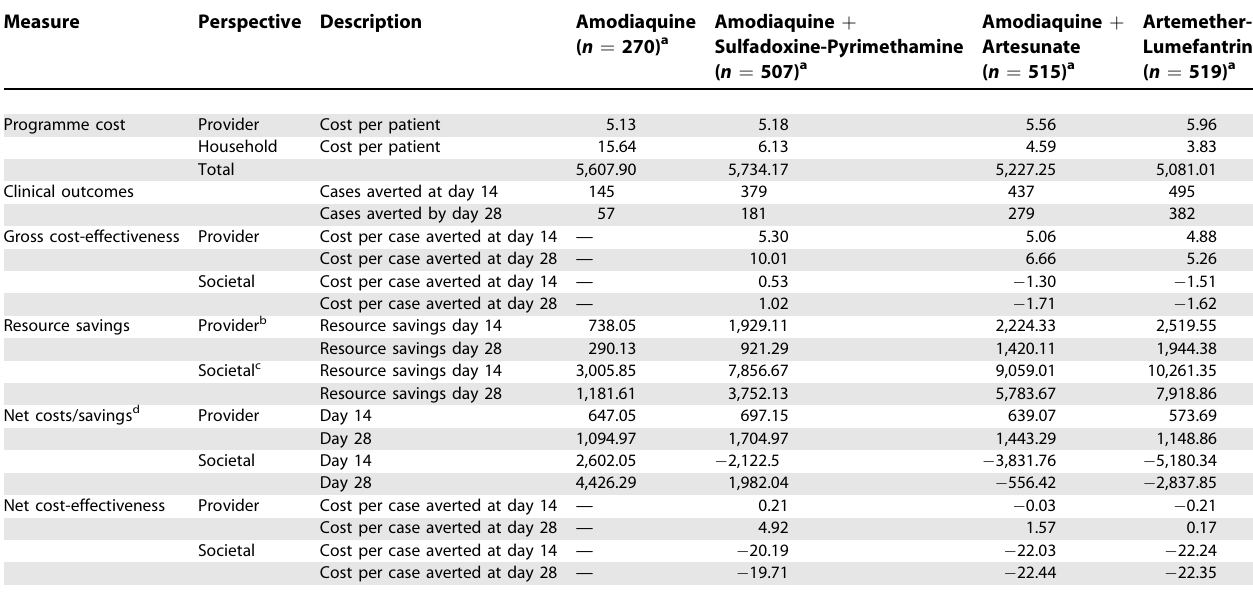
Table 2. Costs (US$), Effects, and Cost-Effectiveness